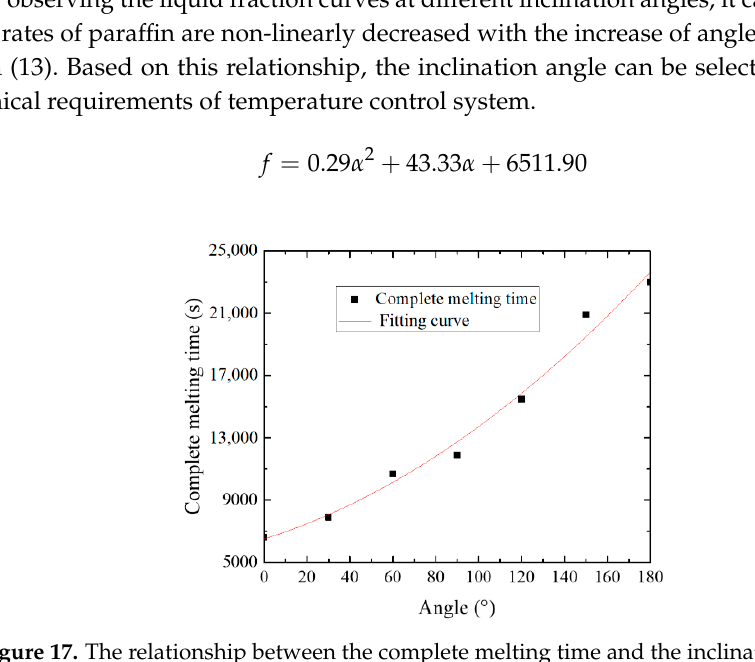
Figure 17. The relationship between the complete melting time and the inclination angles.